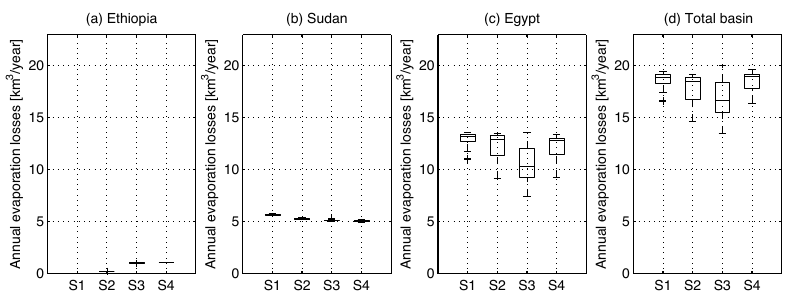
Fig. 6. Box-plots of annual evaporation losses, for the major countries of the basin and for each scenario.